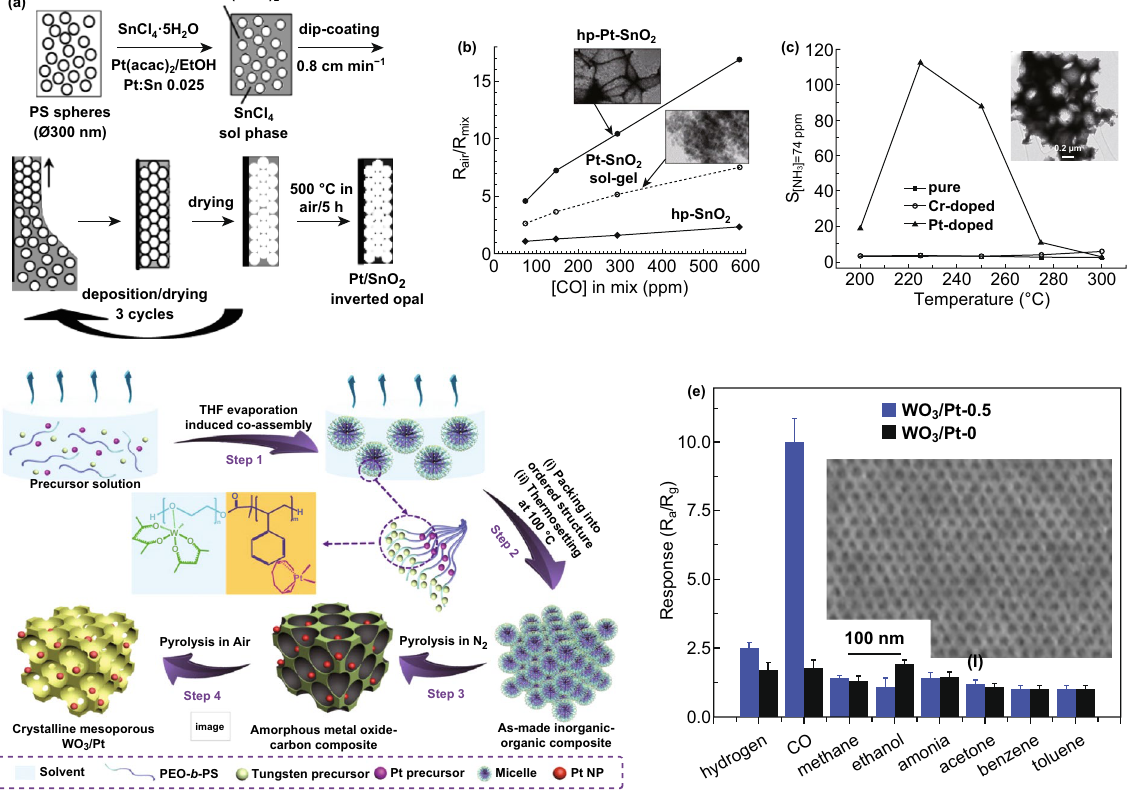
Fig. 4 a Schema of the one-step preparation of Pt-doped SnO 2 -inverted opal films, and b responses comparison of different sensors as a func- tion of CO concentration at 350 °C (insets are the corresponding HRTEM micrographs). Reproduced with permission [103]. Copyright 2010, American Chemical Society. c Responses comparison of different sensors as a function of working temperature to 74 ppm NH 3 gas (the inset is the corresponding HRTEM micrograph of Pt-WO 3 -inverted opal films). Reproduced with permission [104]. Copyright 2011, American Chemi- cal Society. d Synthesis of ordered mesoporous WO 3 /Pt hybrids. e Gas response of WO 3 /Pt-0.5 and WO 3 /Pt-0 to different gases (hydrogen, CO, methane, ethanol, ammonia, acetone, benzene, and toluene) at 100 ppm and 125 °C in 55–60% RH (the inset is an FESEM image of the crystal- line WO 3 /Pt-0.5 viewed from the top surface). Reproduce with permission [56]. Copyright 2018,